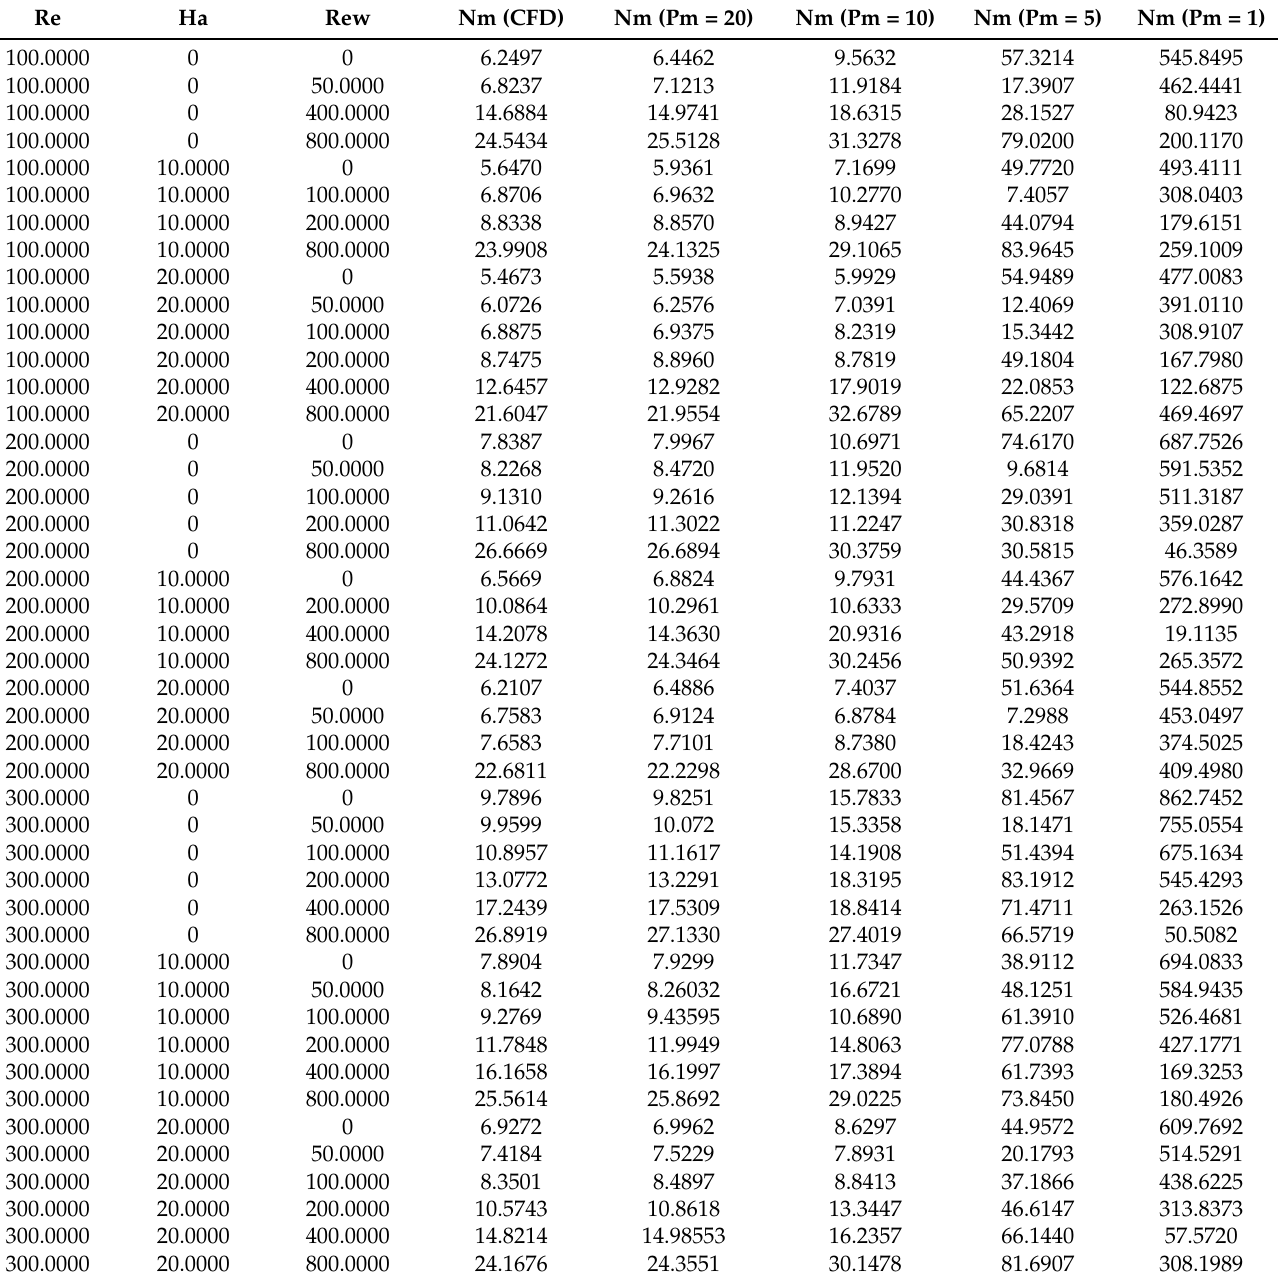
Table 2. Comparisons of modal approximations of average Nu from the hot rotating cylinder with varying Re, Ha and Rew considering different numbers of